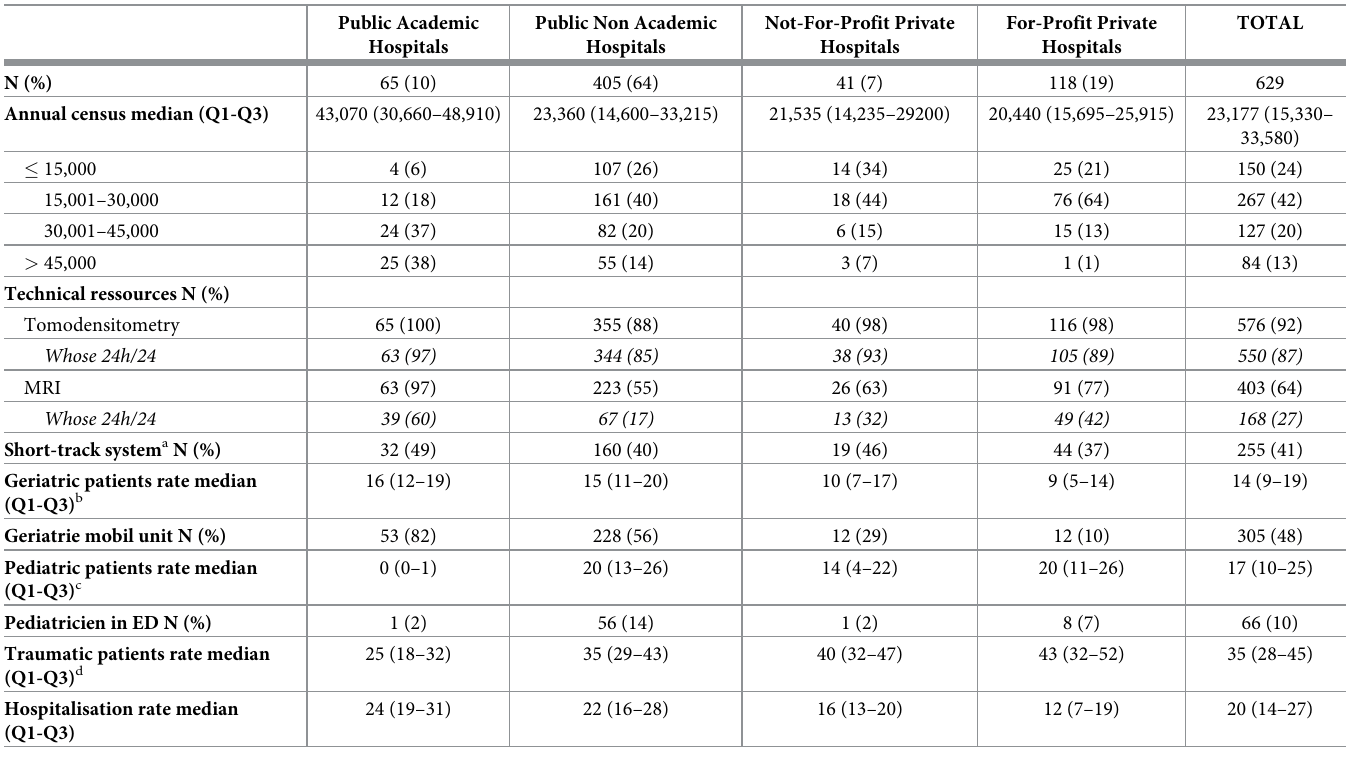
Table 2. Characteristics of general emergency departments.